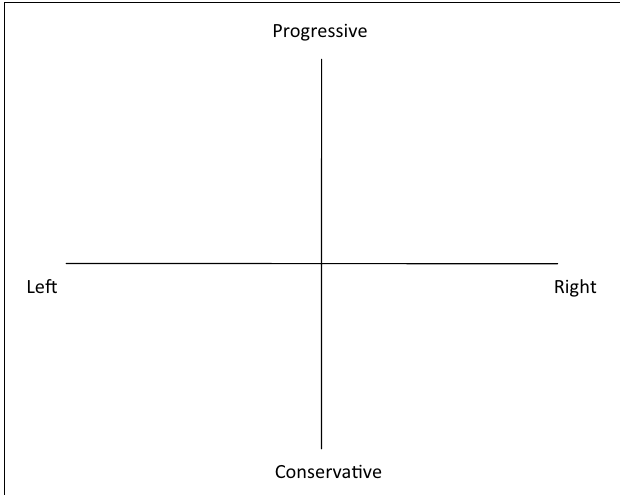
FIGURE 3 | Place the political parties listed below on the correct location in the grid. Then position your own political affiliation in the grid. The political parties to be placed in the grid are: CDA, CU, D’66, GL, PvdA, PVV, SGP, SP enVVD.